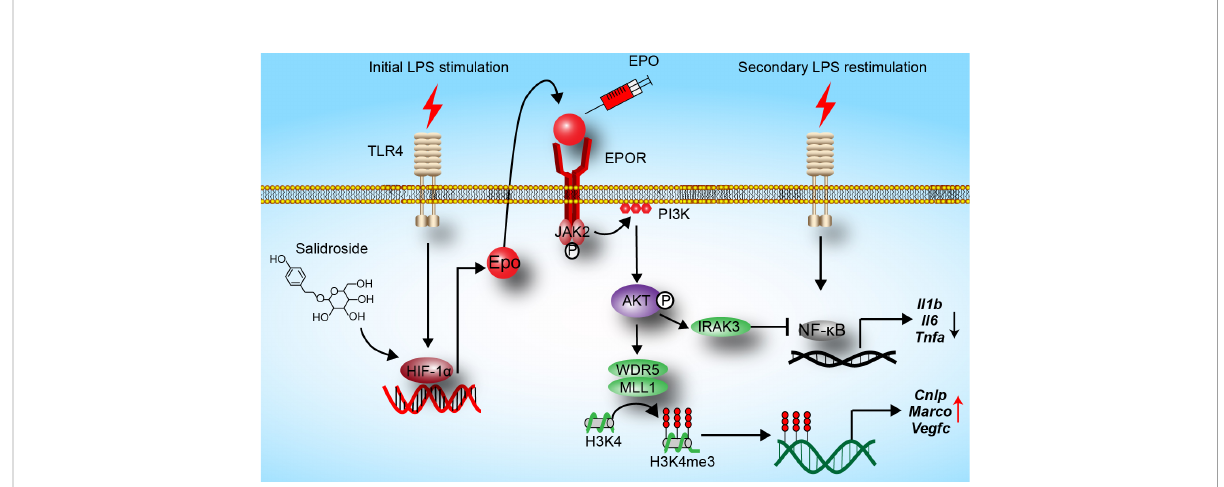
FIGURE 6 Hypothesis schema depicting the mechanism of endotoxin-tolerant re-programming mediated by EPO in macrophages. EPO is induced by initial LPS exposure through upregulation of HIF-1 a . Binding of EPO to its receptor EPOR expressed on macrophages leads to activation of PI3K/AKT pathway, which further upregulated expressions of Irak3 (a negative regulator of LPS response) and Wdr5 (a core scaffolding component of histone methyltransferase complexes). When tolerized macrophages were challenged with a secondary dose of LPS, expression of proin fl ammatory genes such as Il1b , Il6 , and Tnfa was robustly suppressed by IRAK3 via negative regulation of NF- k B, whereas the expression of host protective genes including Cnlp , Marco , and Vegfc in macrophages was upregulated by WDR5-induced histone methylation. In addition, SAL promotes re-programming of endotoxin-tolerant macrophages by inducing endogenous EPO through upregulation of Hif1a